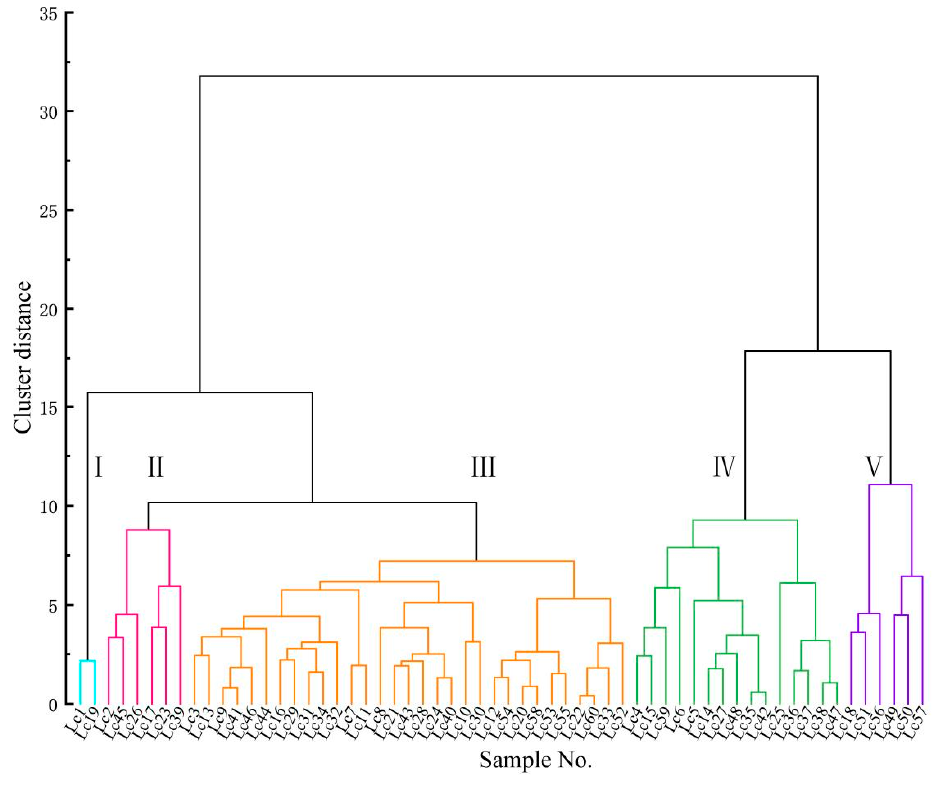
Figure 3. Cluster analysis of flower color in 60 L. chinense var. rubrum based on L* , a* and b * pa- rameters.